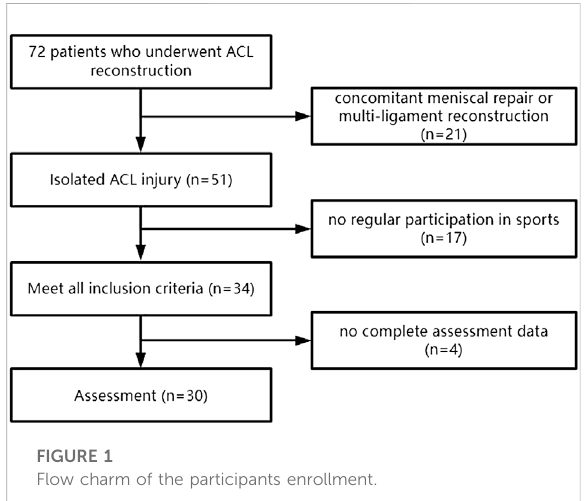
FIGURE 1 Flow charm of the participants